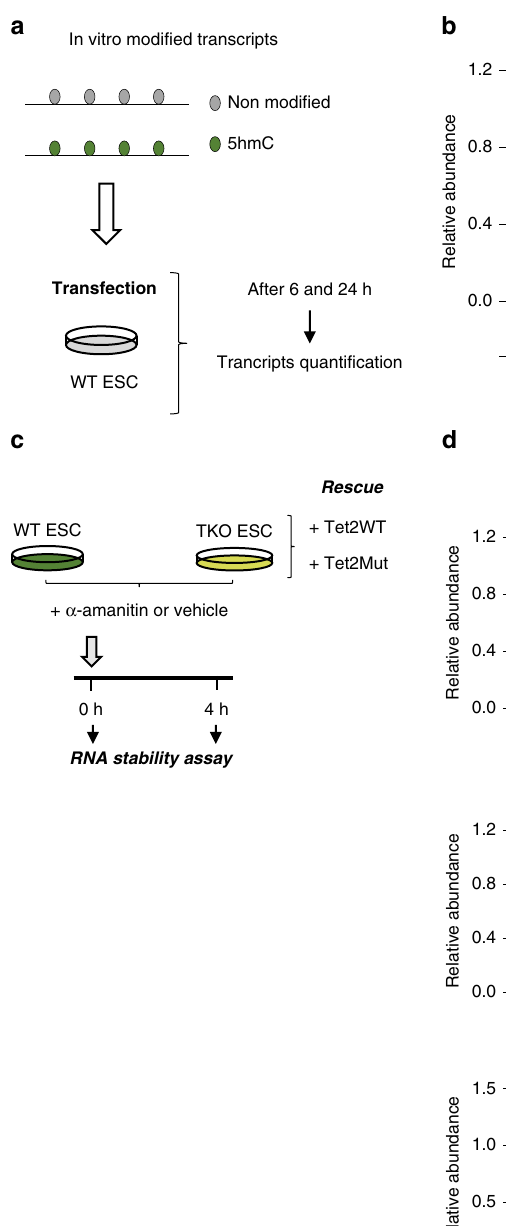
To validate our fi ndings in vivo, we added α -amanitin to WT and TKO ESCs and monitored, by qPCR, levels of key